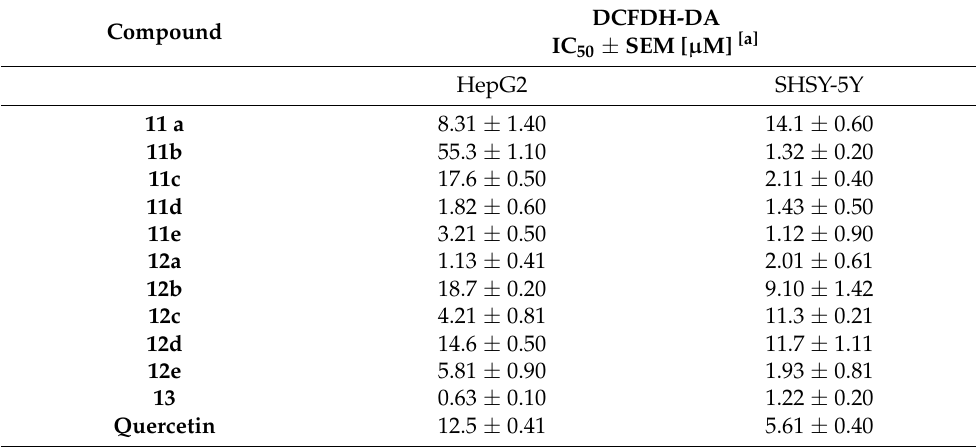
Table 2. Antioxidant potencies in the DCFH-DA assay for the set of compounds under study ( 11a–e , 12a–e , and 13 ) and quercetin.